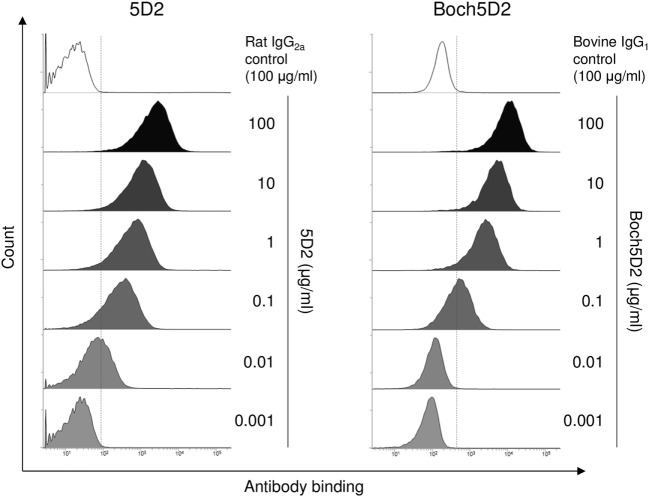
Reactivity of Boch5D2 with BoPD-1-myc cells. Flow cytometric analyses using Boch5D2. BoPD-1-myc cells were stained with 5D2 and Boch5D2 in serial dilutions (from 100 µg/ml to 1 ng/ml).